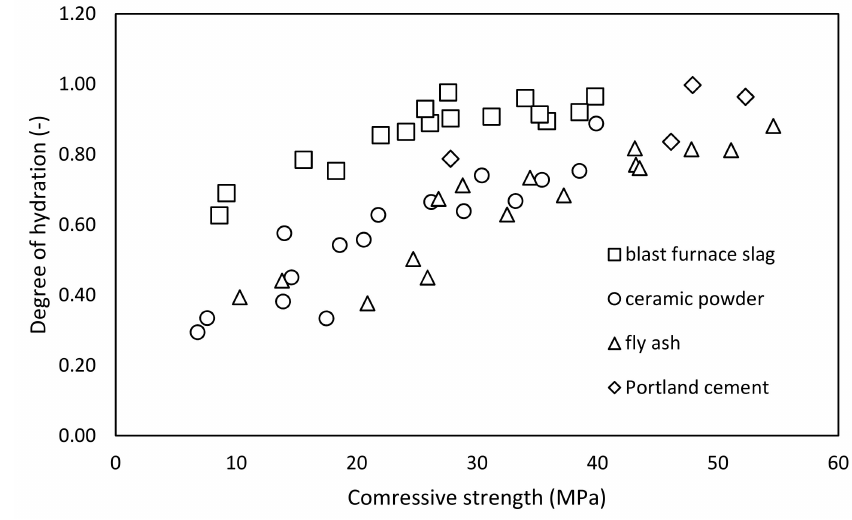
Figure 10. Relation of the degree of hydration and compressive